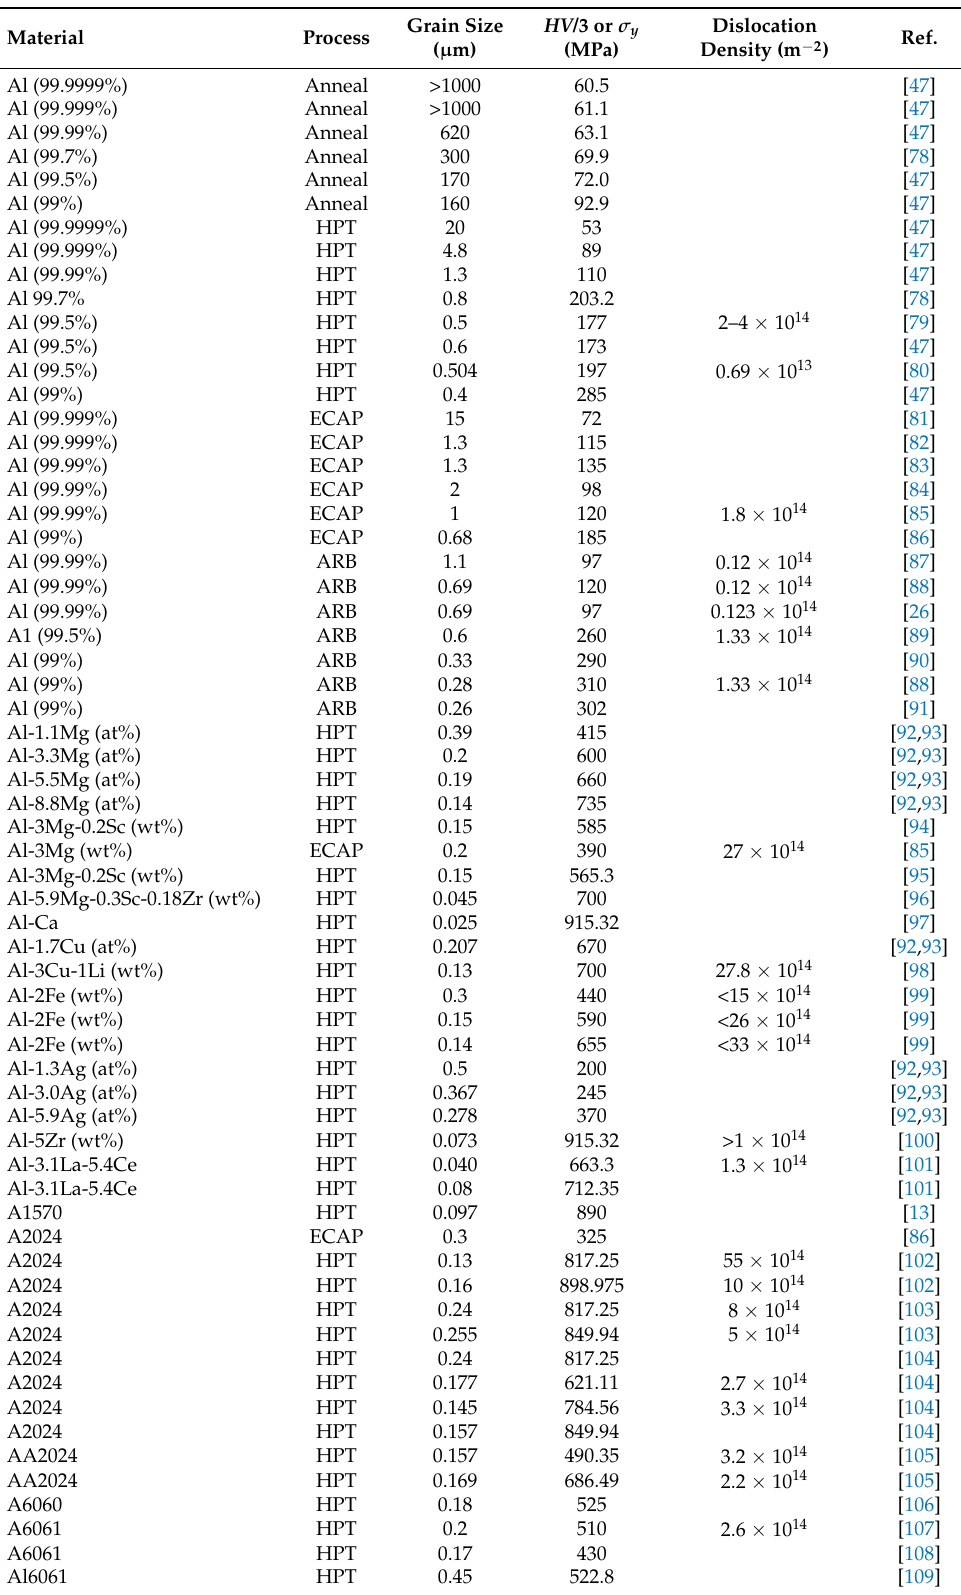
Table A2. Reported experimental data for grain size, yield strength or hardness divided by three, and dislocation density for aluminum and its alloys before and after processing by severe plastic